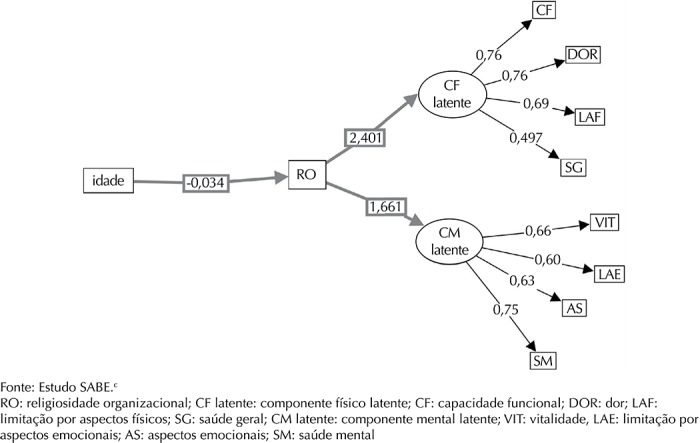
Síntese da modelagem de equações estruturais para o componente físico e mental, sexo feminino. São Paulo, SP, 2006.